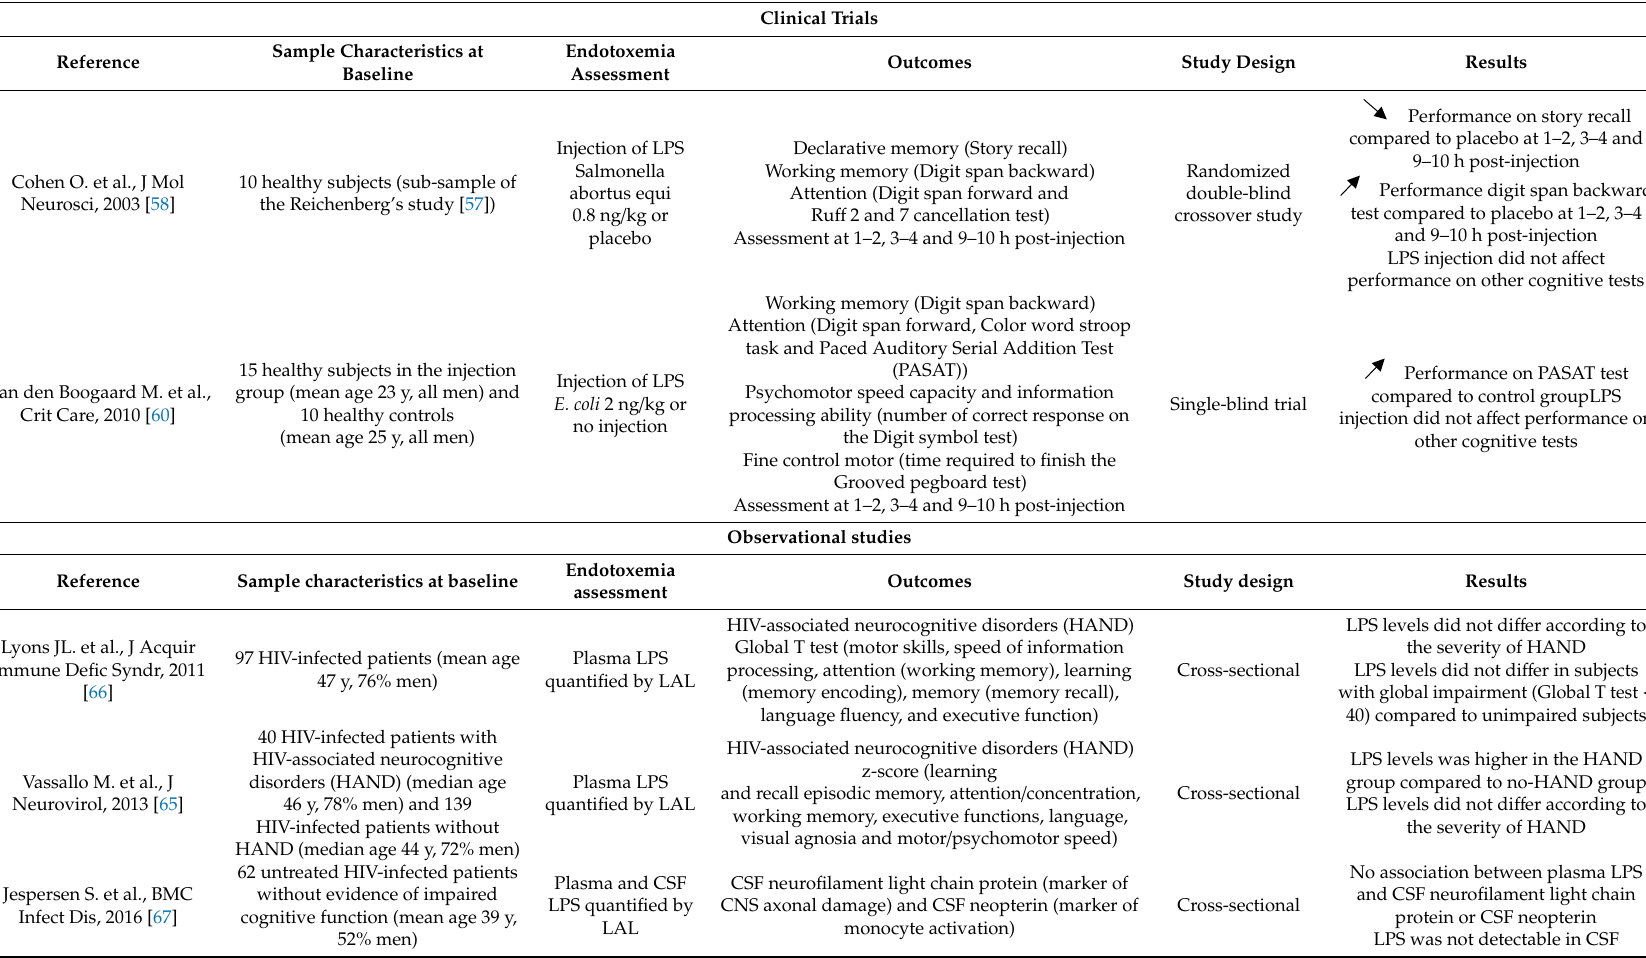
Table 1. Selective evidence on the association between a single high-fat meal and metabolic endotoxemia.